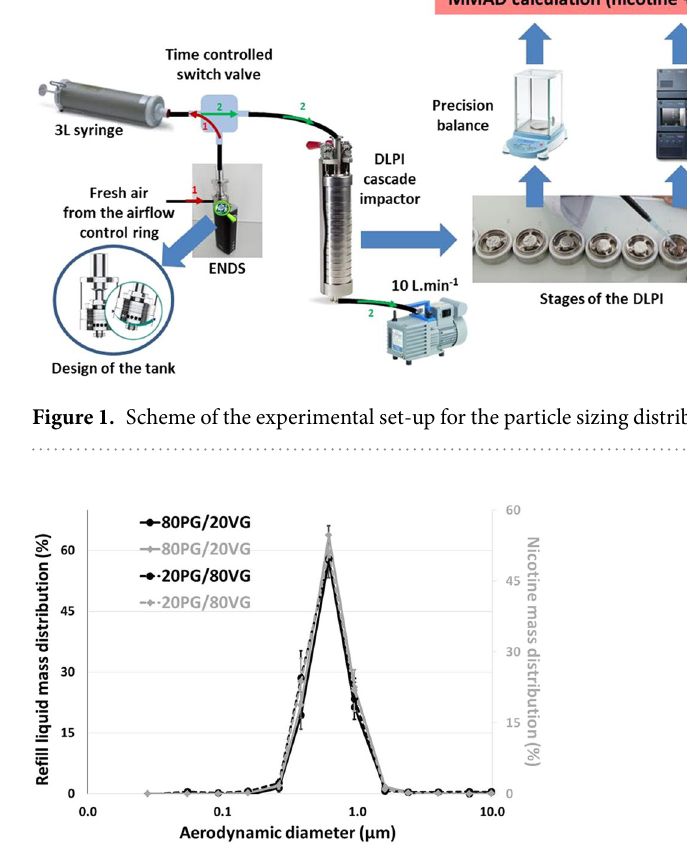
Figure 2. DLPI Impactor-collected data showing the impact of the PG/VG ratio on the frequency mass distribution. Mass of nicotine is in grey (expressed in %) mass of refill liquid in black (expressed in %). The 80PG/20VG formulation was plotted with continuous lines. The 20PG/80VG formulation was plotted with dotted lines. Experiments were performed in triplicate with a power level fixed at 15 W, a dilution ratio of 1.5 and a same volume of aerosol collected into the cascade impactor for all experimental